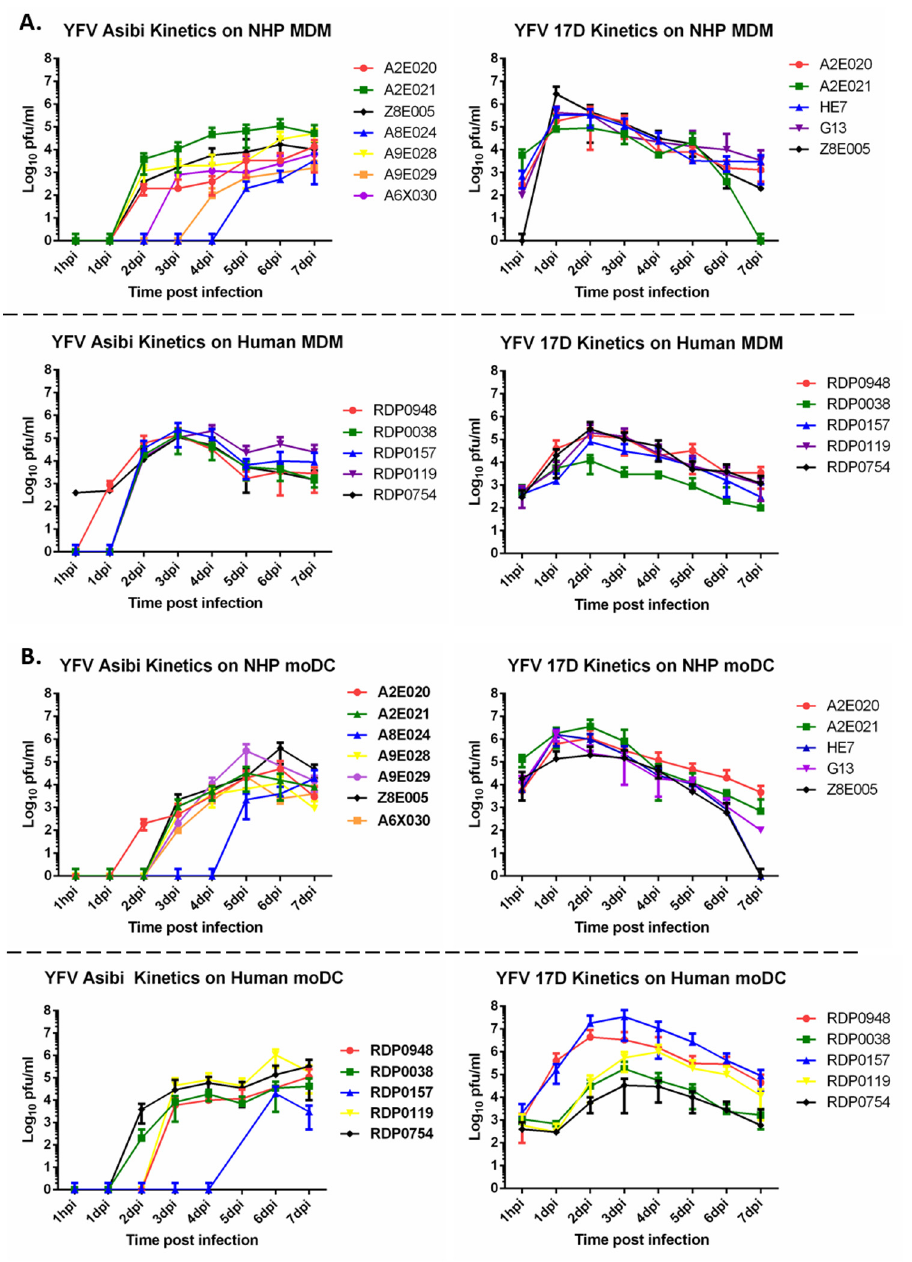
Fig 2. YFV kinetics in MDM and MoDC. Yellow fever propagation kinetics in NHP and human derived (A) MDM and (B) MoDC. Each line represents an individual donor and values in the legend provide the donor reference number. Titrations were performed in triplicate with data points representing the mean of the triplicate values.